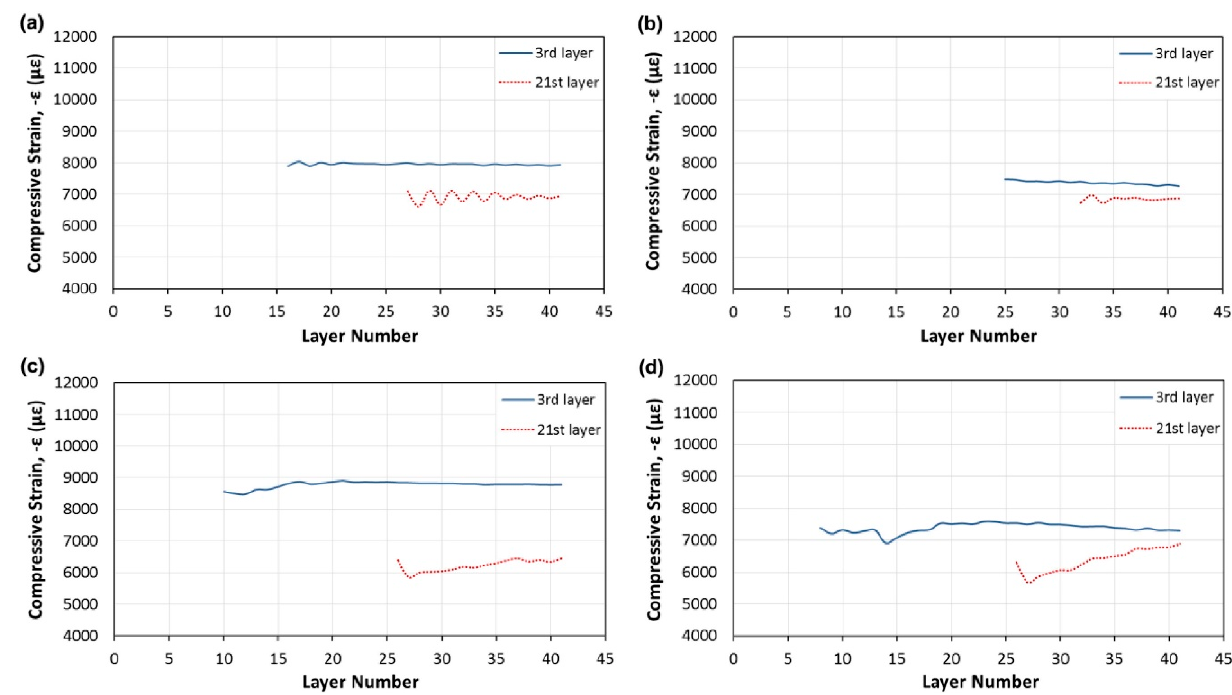
Figure 10. Schematic of a 3D printed neat TP with the location of the FBG sensor and the thermo- couple [72] (copyright (2016), with permission from Elsevier).